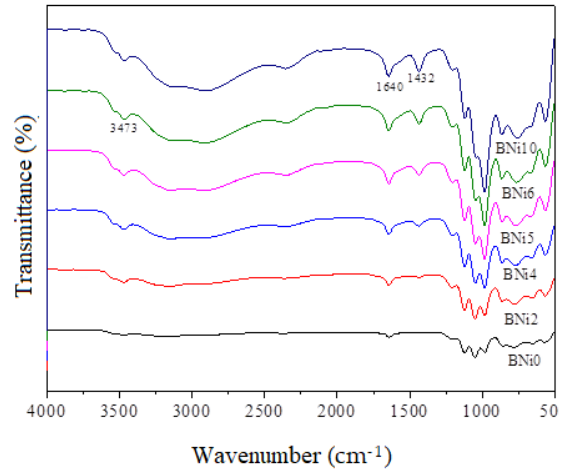
Figure 4. FT-IR spectrum of Ca x Ni 1-x HPO 4 ·nH 2 O compounds.